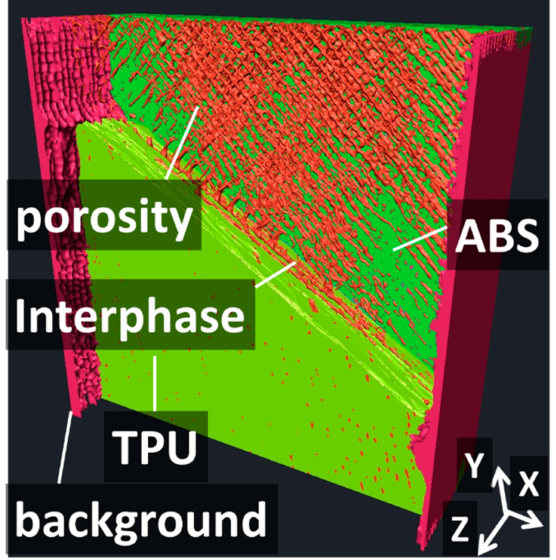
Figure 5. Perspective view showing the layering structure, porosity network, and roughness in the ABS-TPU composite, revealed using X-ray micro-tomography.